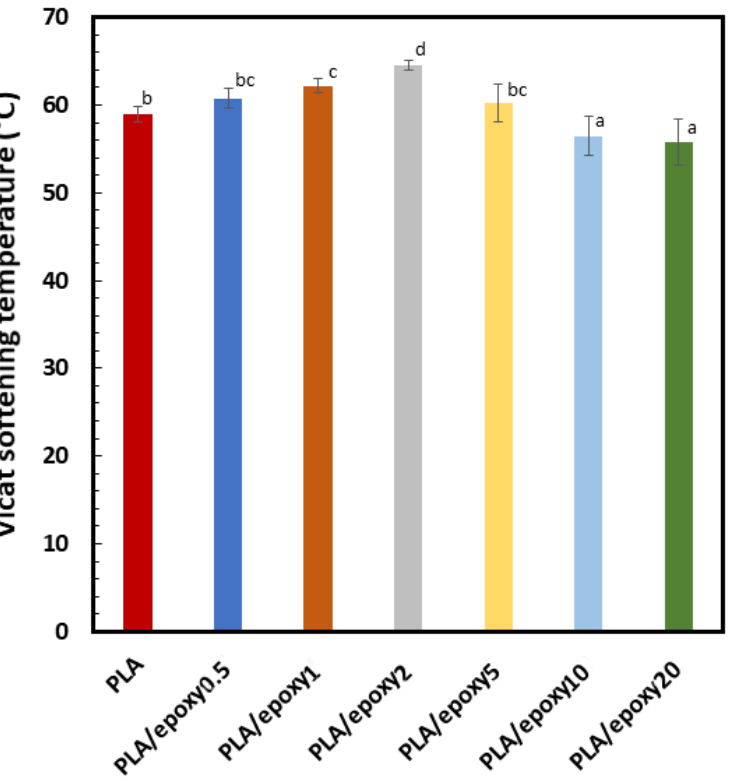
Figure 4. The Vicat softening temperature of PLA and the PLA blend with 0.5–20% epoxy. The mean values indicate by the different lowercase letters differ significantly ( p <